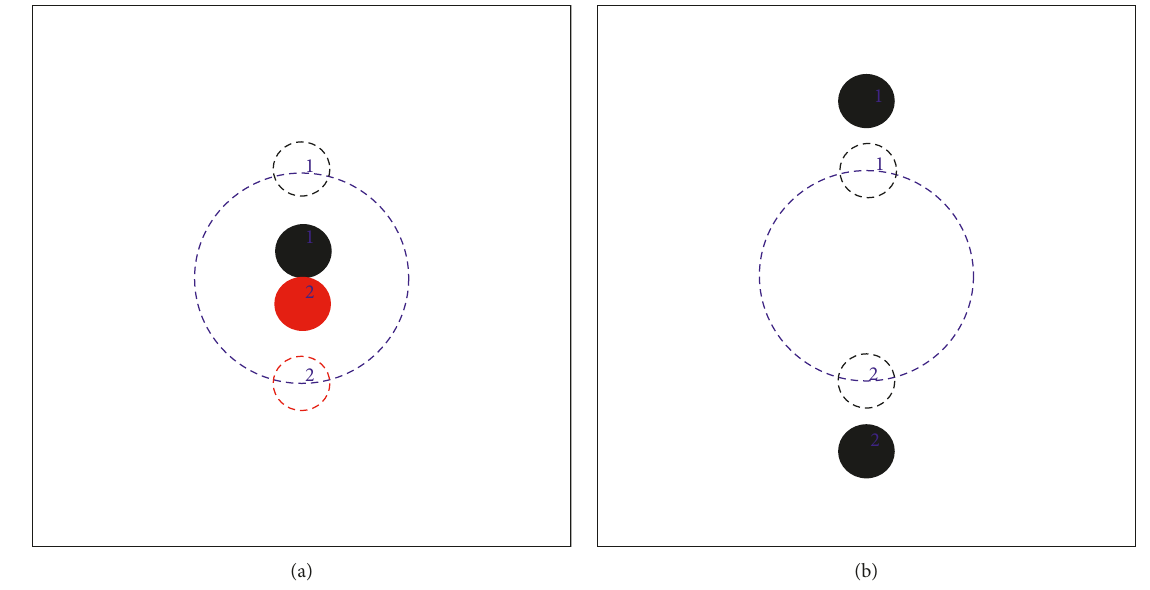
Figure 2: Two particles (red or black dashed line) are initially equispaced on a circle (blue dashed line) with θ field with E 1kV/m along x direction, and then the final particle chains (solid particles) are, respectively, shown after DEP interaction (cid:31) under different statuses: (a) two negative (black) DEP particle, (b) one positive (red) and one negative DEP